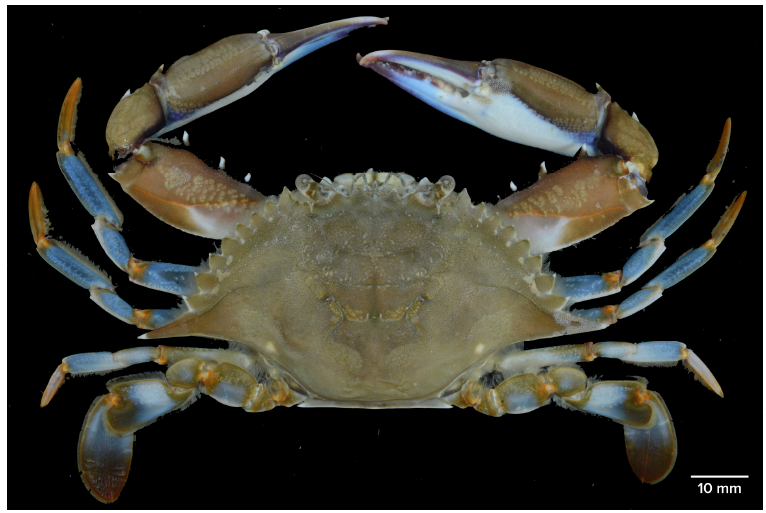
Figure 1. Adult male of Callinectes ornatus Ordway, 1863 (ULLZ 15990). Photo by DL Felder.